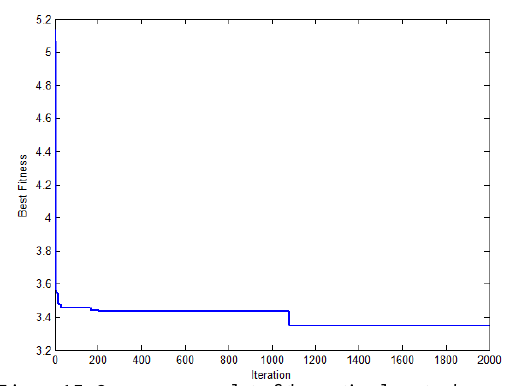
Figure 15. Convergence plot of the optimal route shown in Figure